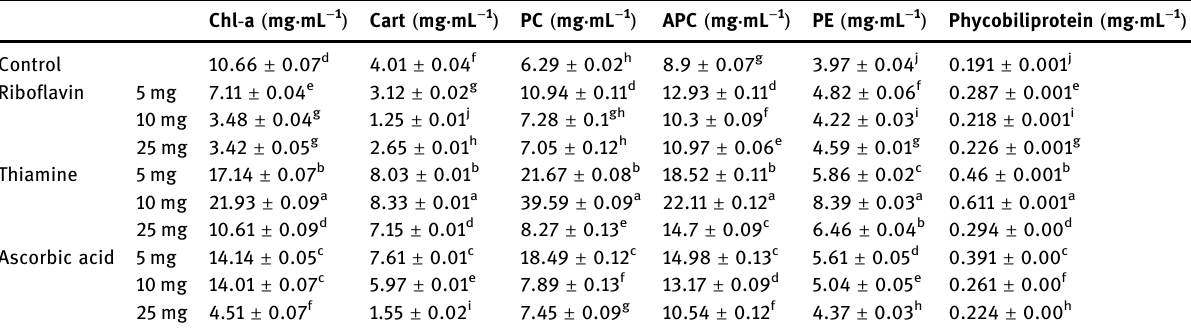
Table 4: Mean values of chlorophyll, carotenoids, and phycobilins concentrations ( mg · mL − 1 ) in SP supplemented with various concen - trations of ribo fl avin, thiamine, and ascorbic acid for 21 days of